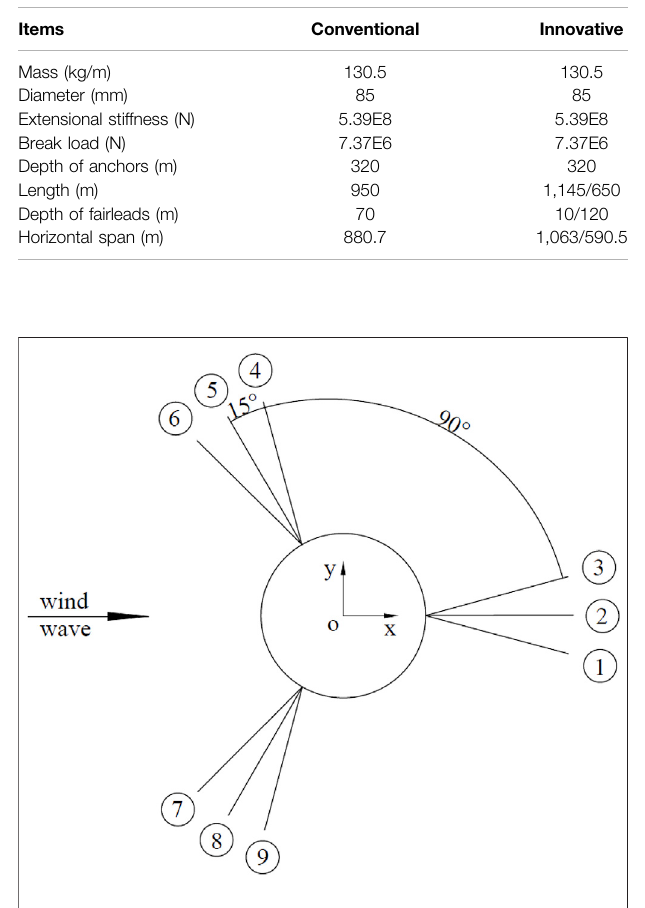
FIGURE 3 | Top view of the mooring lines layout (the top views of two mooring systems are the